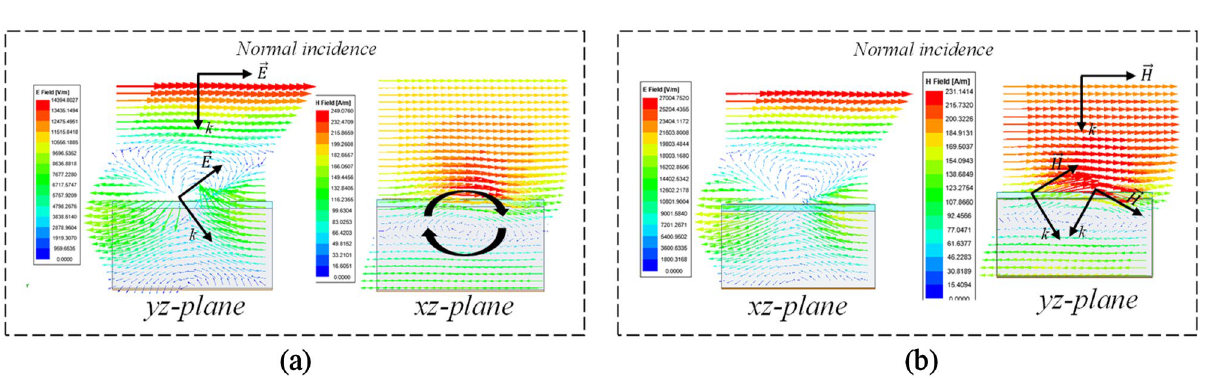
Figure 3. Electrical and magnetic fields for ( a ) TE 00 mode, and ( b ) TM 00